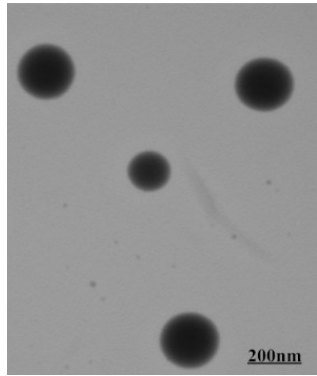
Figure 1. TEM image illustrating the self-assembly behaviors of IL-POSS-Br in ethanol.